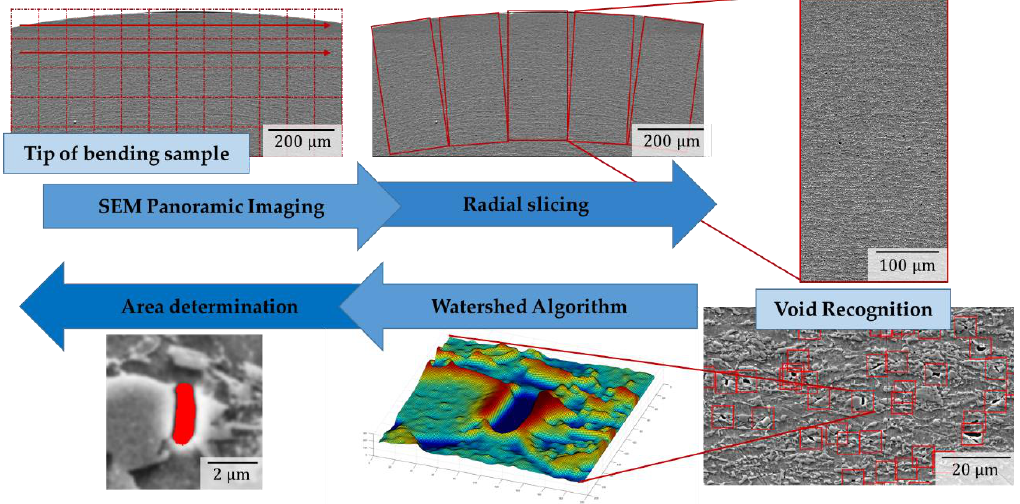
Figure 3. Schematic representation of void area measurements from panoramic SEM imaging. Individual images are stitched and voids recognized via a grayscale threshold. The identified voids are then individually processed using a watershed algorithm to measure their size.